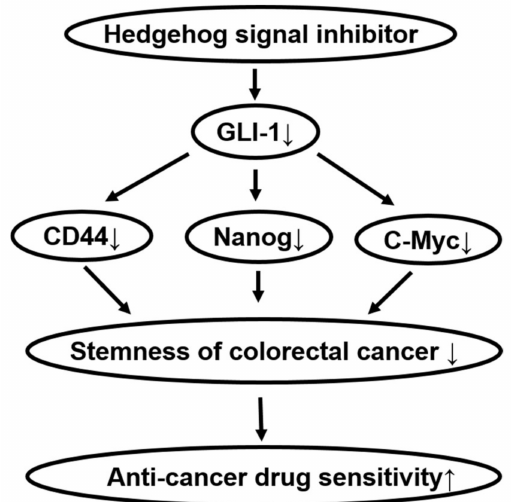
Figure 2. Summary of the present results. GLI-1-targeted Hedgehog signal inhibitors improved the sensitivity for anti-cancer drug treatment in tumor ALI organoids at least in part through the decrease of CD44, Nanog, and c-Myc